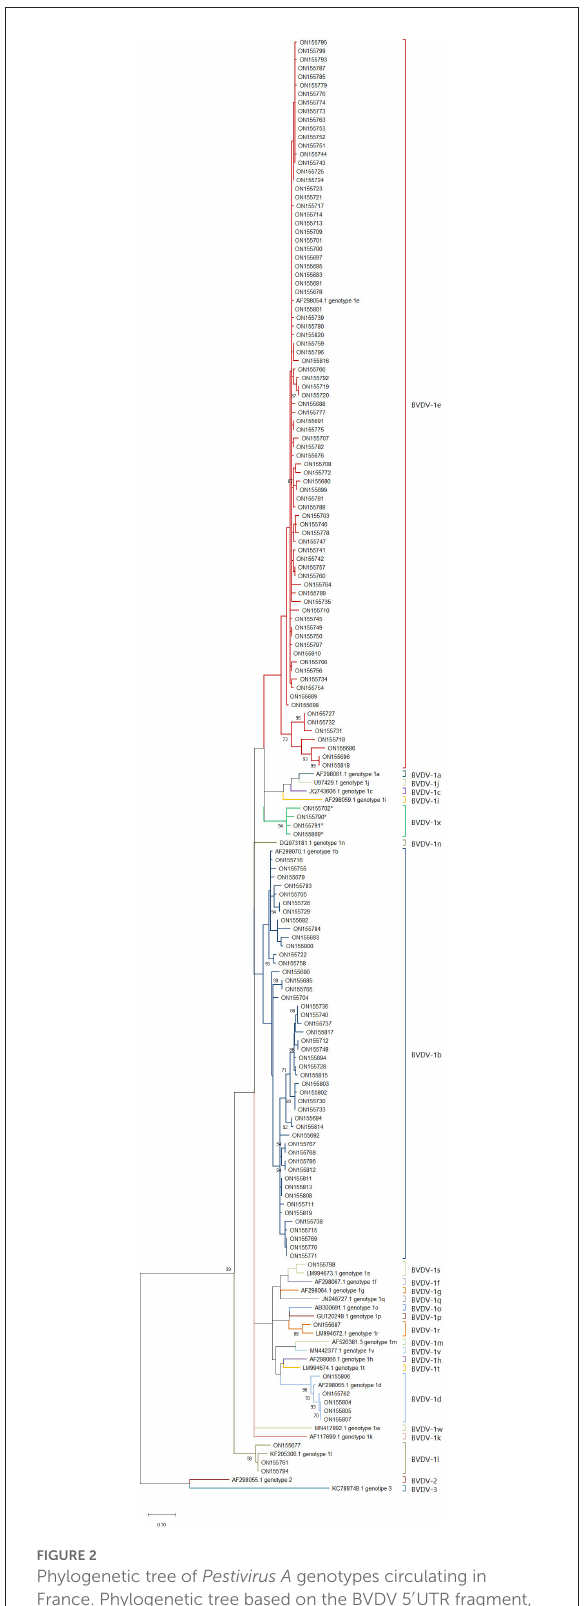
FIGURE2 Phylogenetic tree of Pestivirus A genotypes circulating in France. Phylogenetic tree based on the BVDV 5 ′ UTR fragment,